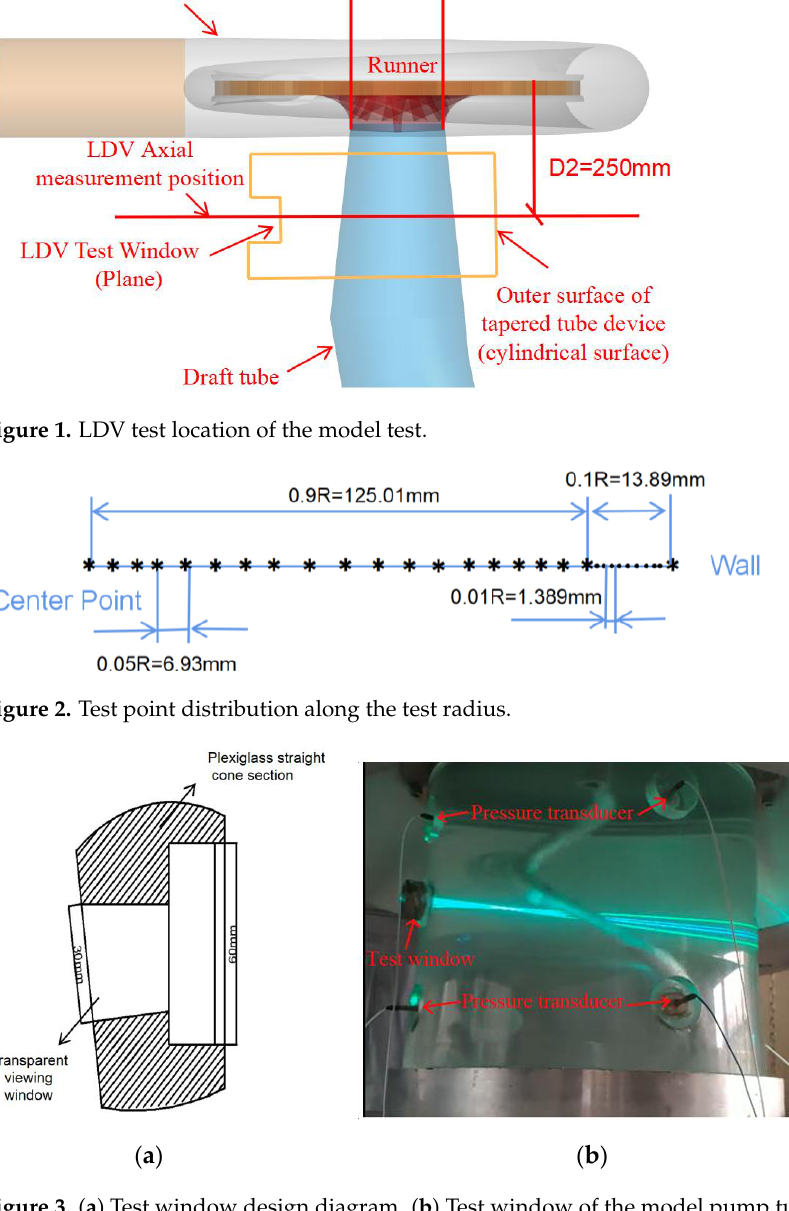
Figure 3. ( a ) Test window design diagram. ( b ) Test window of the model pump turbine.